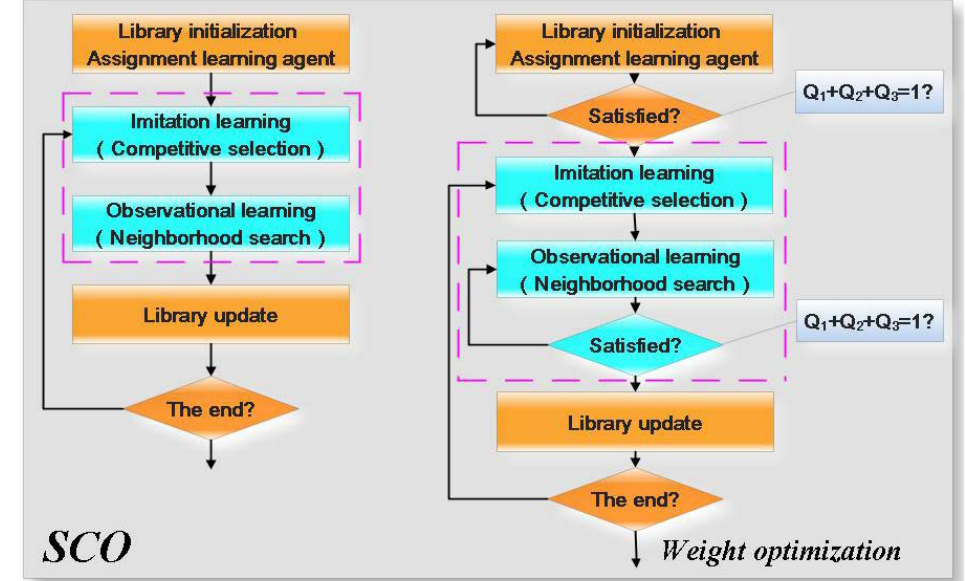
Figure 2. The flowchart of the SCO algorithm and the weight optimization.